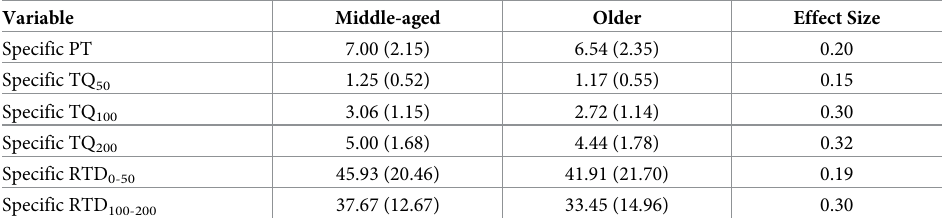
Table 3. Torque parameters normalized to muscle cross-sectional area for both